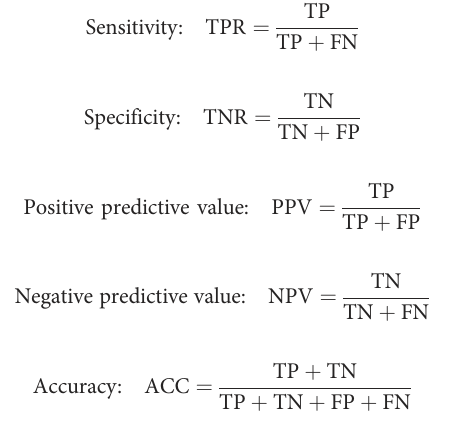
TABLE 1 Binary classi fi cations for CNN models and human experts in test dataset ( n =200). AUC with 95% con fi dence intervals in parentheses); P Δ , P -values for pairwise comparison of ROC curves, using the DeLong method; TPR, sensitivity; TNR, speci fi city; PPV, positive predictive value;